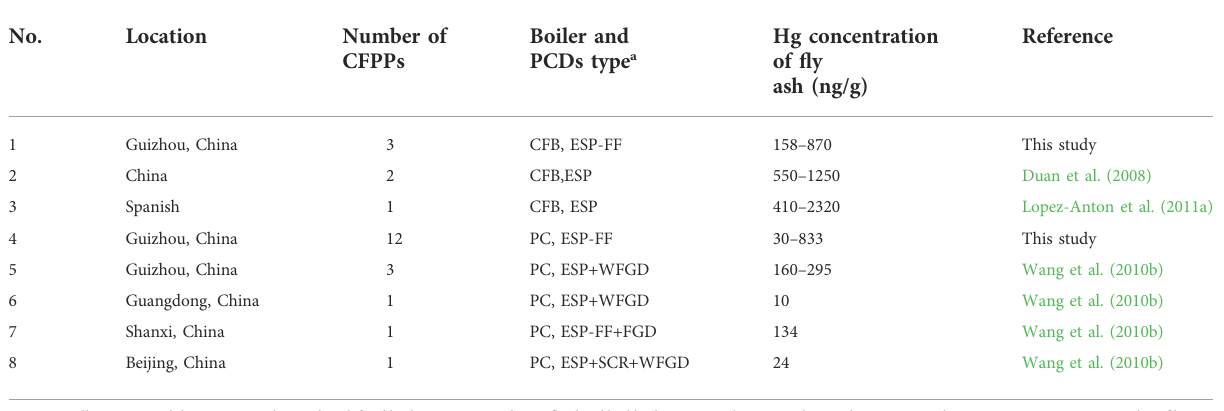
TABLE 3 Comparison of Hg concentrations in fl y ash from different CFPPs.